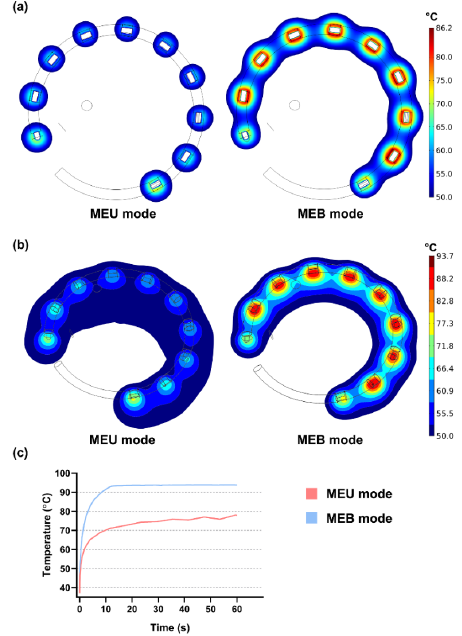
Figure 4. ( a ) Temperature distribution on the tissue surface and ( b ) inside of the myocardium in the MEU and MEB modes at 60 s of RFCA. ( c ) The maximum temperature detected in the myocardium during 60 s of